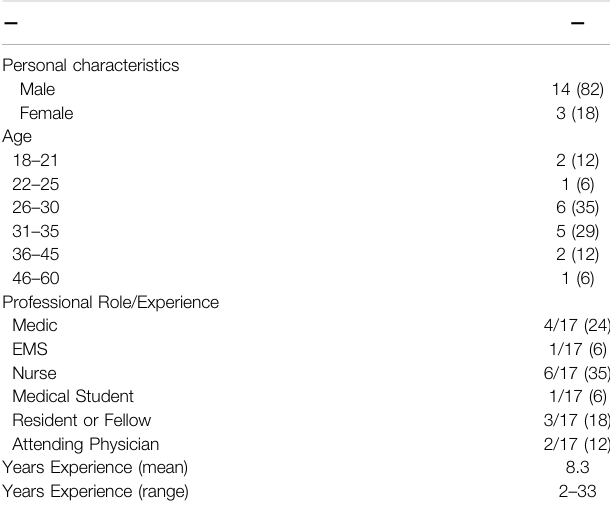
TABLE 2 | Demographics of 17 participants. Values are numbers (rounded percentages) of